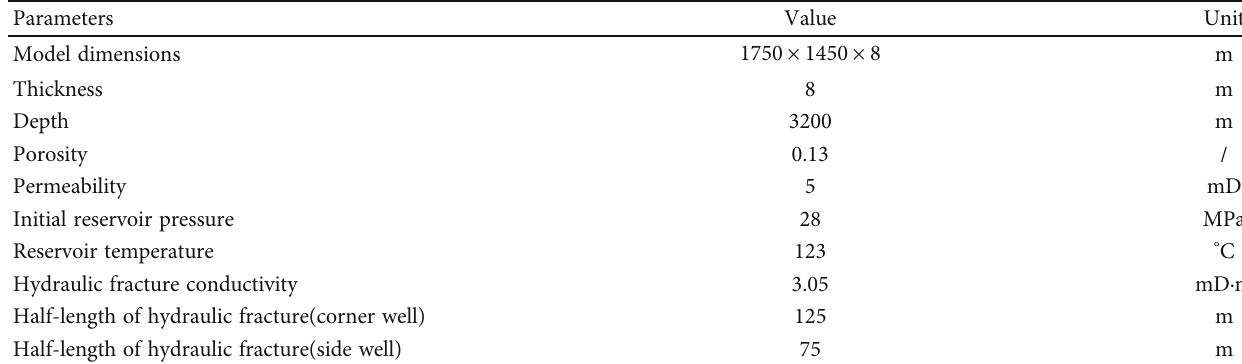
Figure 5: Daily water injection rate. Table 1: List of model